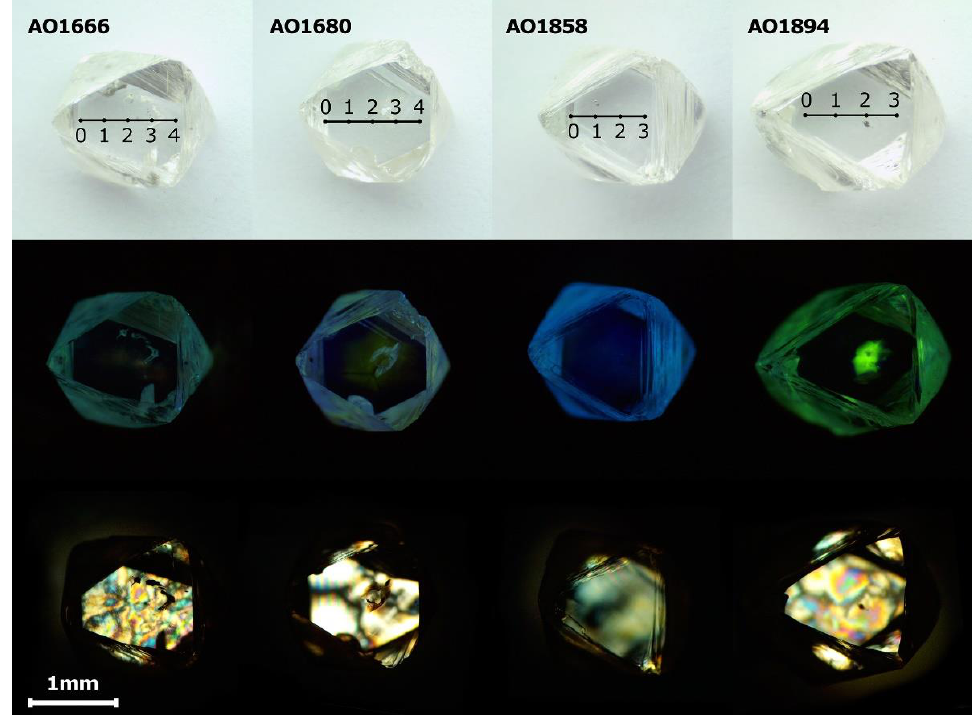
Figure 1. Optical microscopic photographs, photoluminescence images, and birefringence images of AO1666, AO1680, AO1858, and AO1894 samples after polishing. The photoluminescence (PL) images were made with excitation at λ = 405 nm using a 450 nm filter. The AO1666 shows birefringence known as a “tatami” type, typical of type IIa diamonds. The bright birefringence of the AO1666 and AO1894 crystals demonstrates the vulnerability of low-nitrogen diamonds to plastic deformation. The birefringence pattern of the AO1680 crystal reflects the zonal structure and correlates with the photoluminescence image. The AO1858 crystal demonstrates birefringence typical of type I diamonds with a number of dislocations.